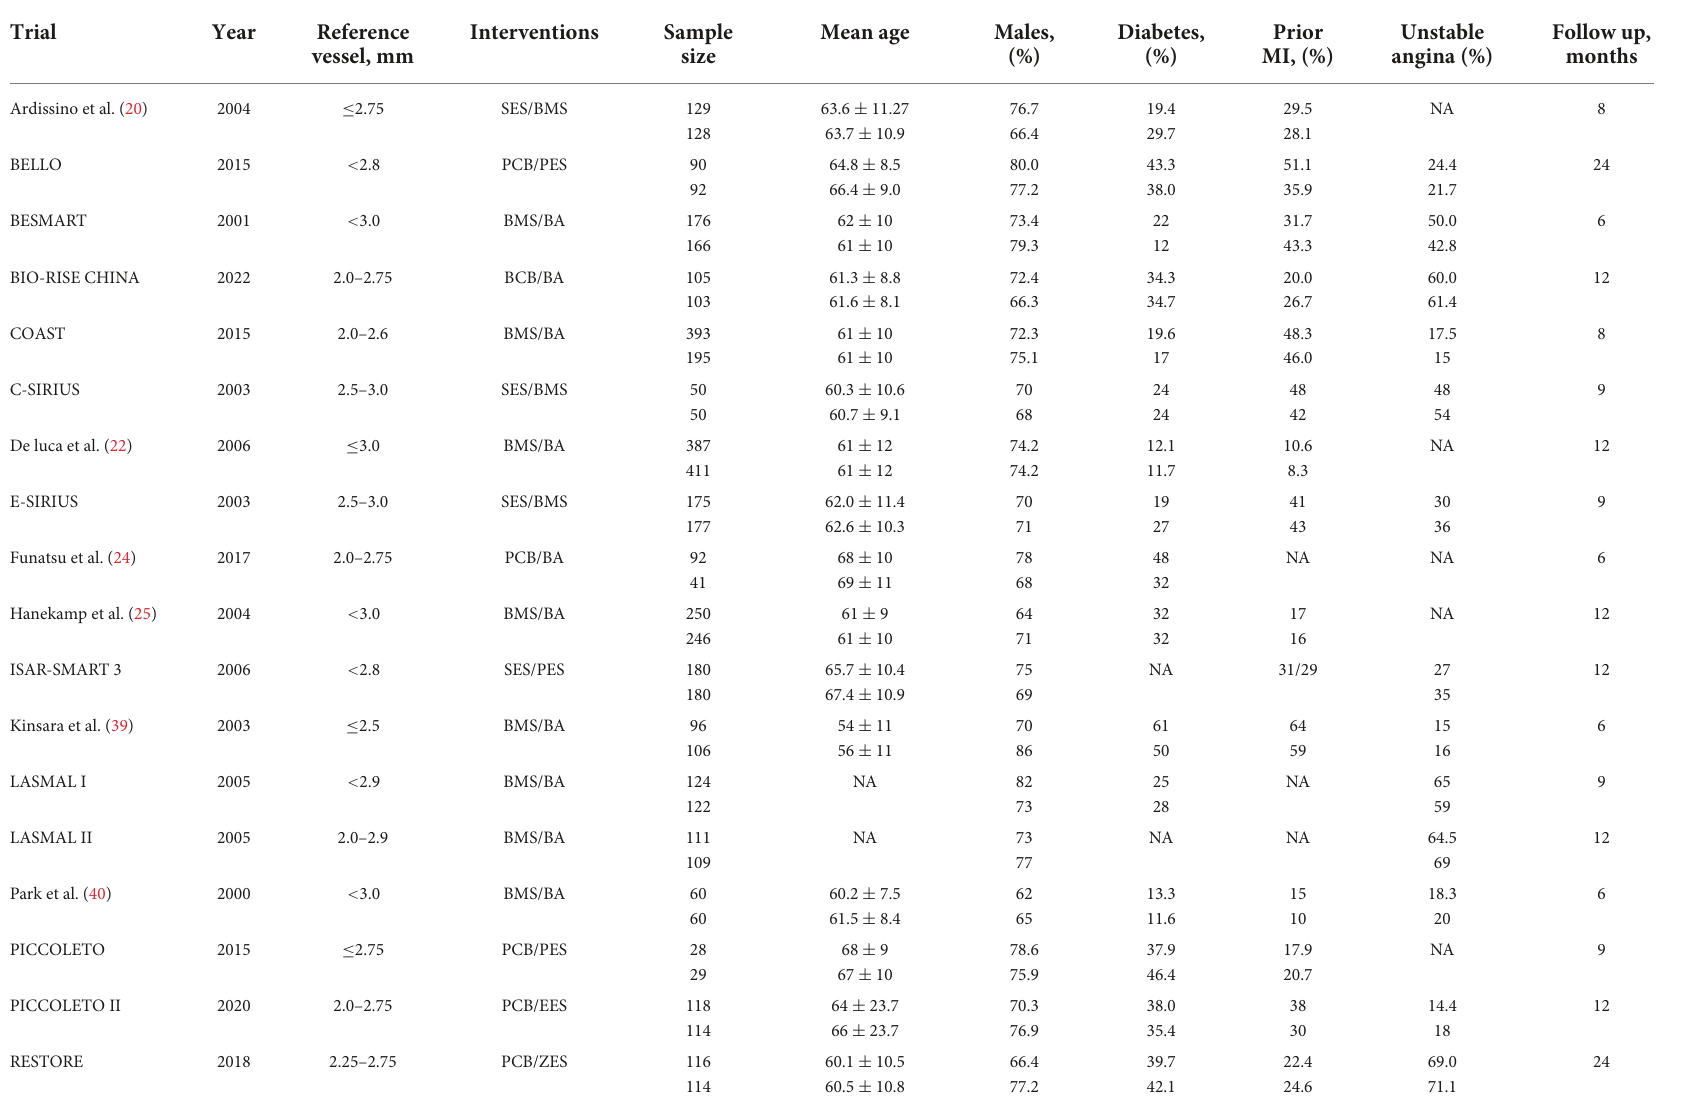
TABLE 1 Basic characteristics of included